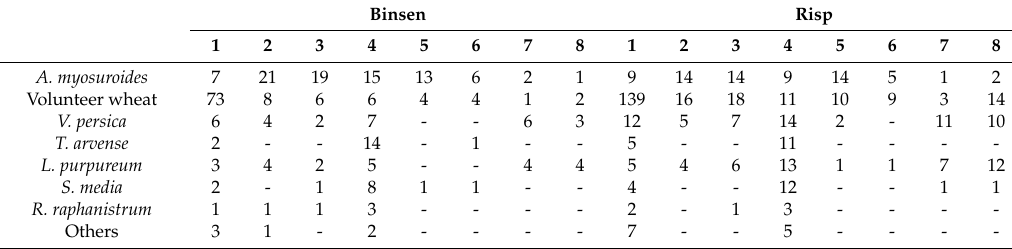
Table A1. Mean number of weed species (averaged over all counting dates) per m 2 for the eight treatments (averaged for the treatments with the presence and the absence of straw) at the field sites Binsen and Risp. 1: untreated control; 2: flat soil tillage; 3: deep soil tillage; 4: ploughing; 5: single glyphosate application; 6: dual glyphosate application; 7: cover crop mixture + mulch-till; 8: